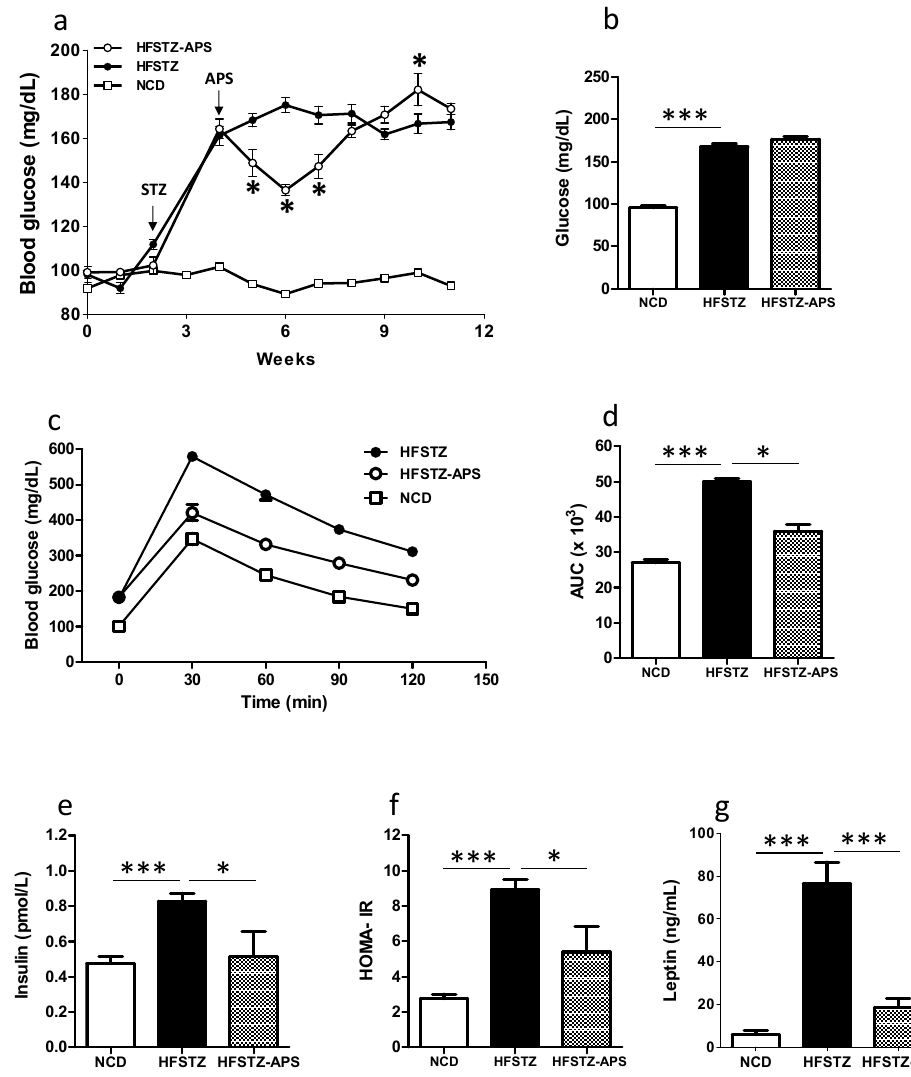
Figure 2. APS ameliorated HFSTZ-impacted glycemic control. Three groups of APP/PS1 mice: normal chow diet (NCD) ( n = 6), high fat diet plus streptozotocine (HFSTZ) ( n = 7) or HFSTZ plus APS (HFSTZ-APS) ( n = 6) are examined. ( a ) Fasting glucose levels detected every week; ( b ) Fasting glucose levels detected at 11 weeks after dietary manipulation; ( c ) Oral glucose tolerance testing was performed 10 weeks after dietary manipulation; ( d ) Area under curve (AUC) values of panel c; ( e ) Fasting insulin; ( f ) homeostasis model assessment of insulin resistance (HOMA-IR), and ( g ) leptin were determined at 11 weeks after dietary manipulation. Bars represent the mean ± SEM. * p < 0.01 and *** p < 0.001, significant difference from HFSTZ group.